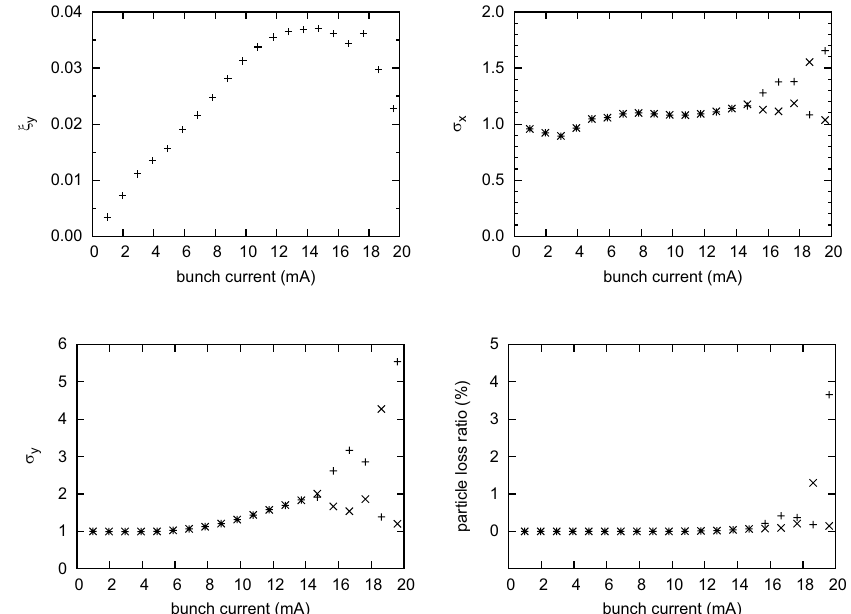
(cid:3) (cid:7) (cid:1) 0 : 51 ; 0 : 57 (cid:3) . The size ; 7 x y